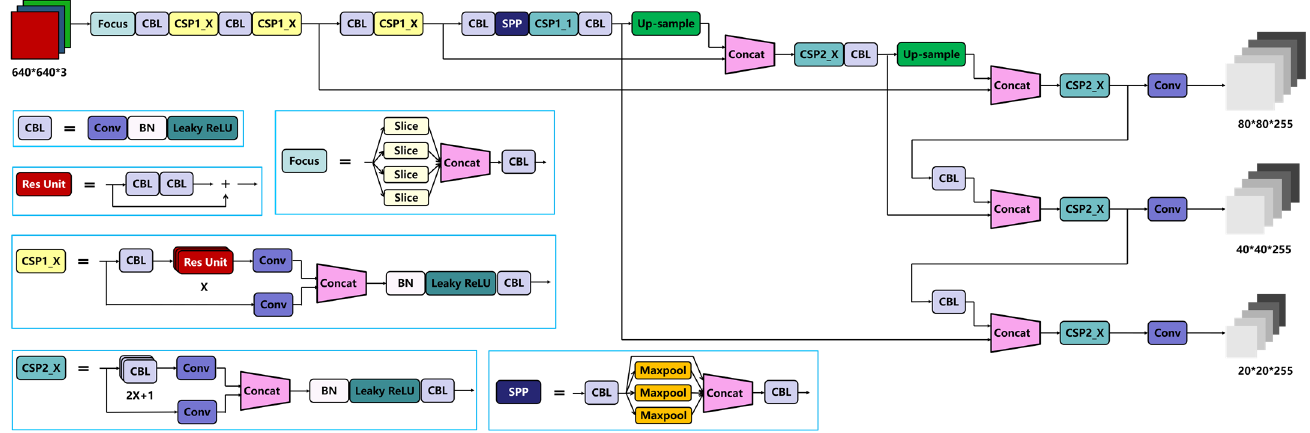
Figure 4. Structure of YOLOv5.